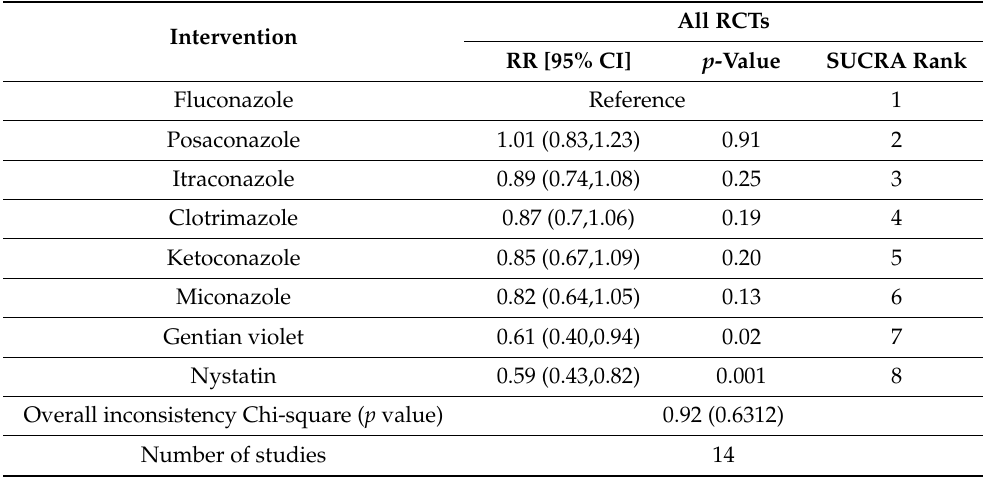
Table 2. Network estimates and SUCRA ranking of the efficacy of antifungal agents used for the treatment of OPC among HIV-infected adults (clinical